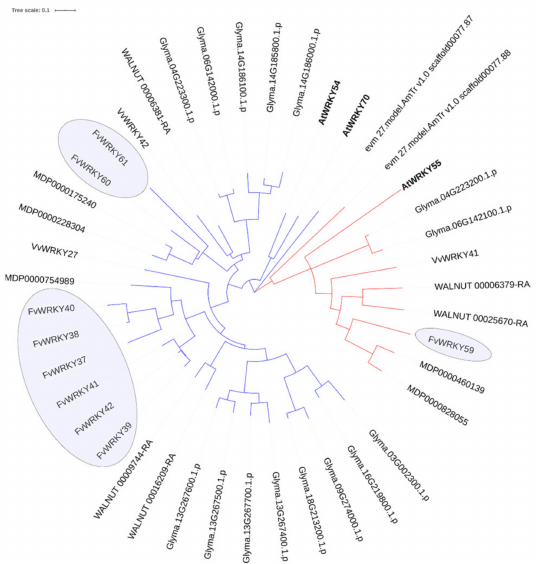
Figure 7. Phylogenetic tree of the AtWRKY55 and AtWRKY54/70 orthologous genes (red and blue branches, respectively) in strawberry (Fv), soybean (Glyma), walnut (WALNUT), apple (MD), grapevine (Vv) and Amborella ( AmTr ). Strawberry orthologs to AtWRKY54/70 paralogs underwent tandem duplications after the gamma hexaploidization and independently to the more recent WGD events in other species. The evolutionary history was inferred using the Maximum Likelihood method (100 bootstraps) with optimized parameters (TN + G + I). The tree is drawn to scale, with lengths of branches representing the number of substitutions per site. Analyses were conducted in